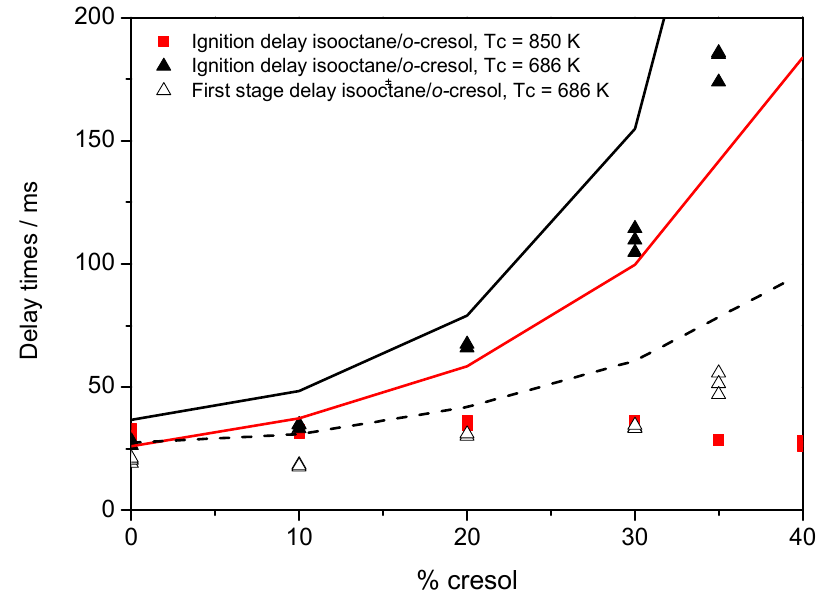
Figure 2. Experimental (symbols) and simulated (lines) evolution of the first-stage (open symbols, dashed line) and total (full symbols, solid lines) ignition delay times of stoichiometric iso -octane/ ortho -cresol blends as a function of the molar content in ortho -cresol. T C = 686 ± 7 K (black), 850 ± 5 K (red), P C = 20 bar.